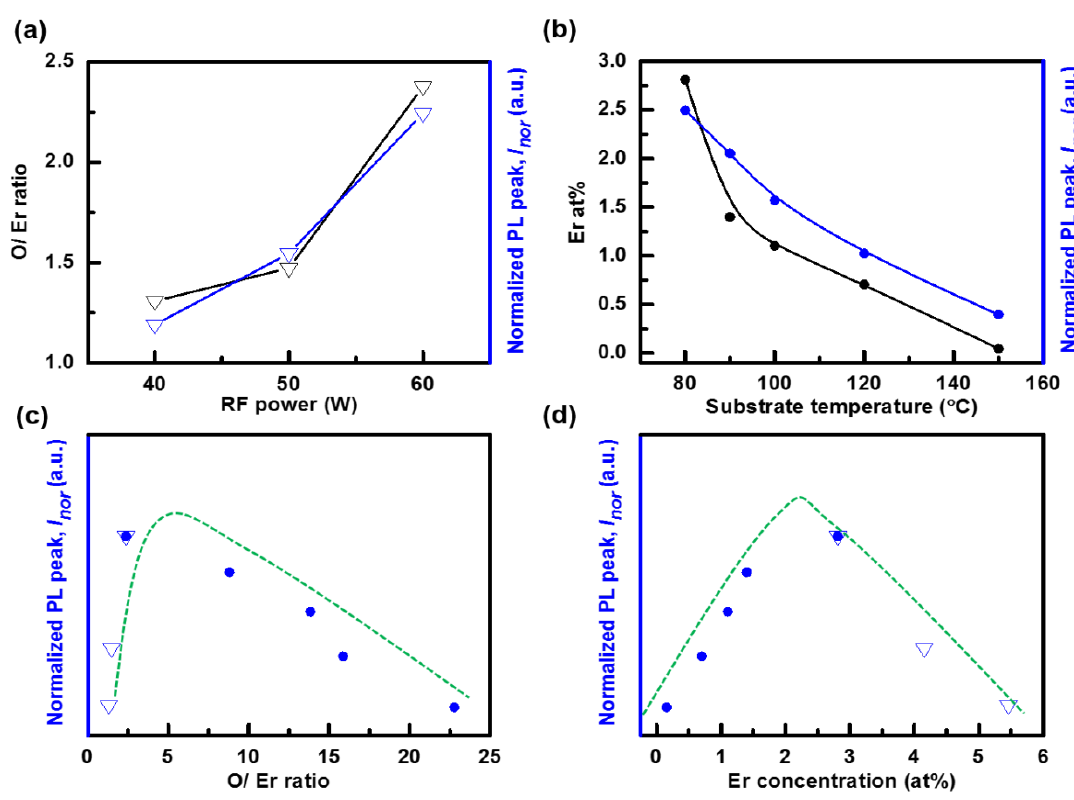
Figure 3. ( a ) The [O]/[Er] ratio (black triangle) and normalized PL peak intensity (blue triangle) as a function of the applied RF power with a substrate temperature of 80 °C; ( b ) The Er concentration (solid black circle) and normalized PL peak intensity (solid blue circle) as a function of the substrate temperature with an RF power of 60 W. The normalized PL peak intensity is shown to depend critically on the ( c ) [O]/[Er] ratio; and ( d ) [Er]. The lines are guides to the